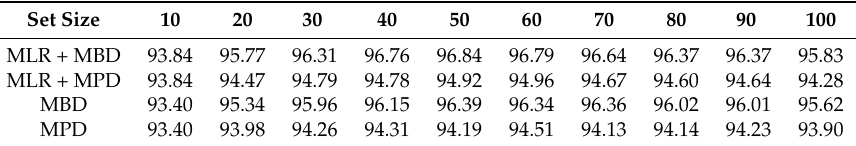
Table 13. Set size discussion for set-based dissimilarity on MLII.